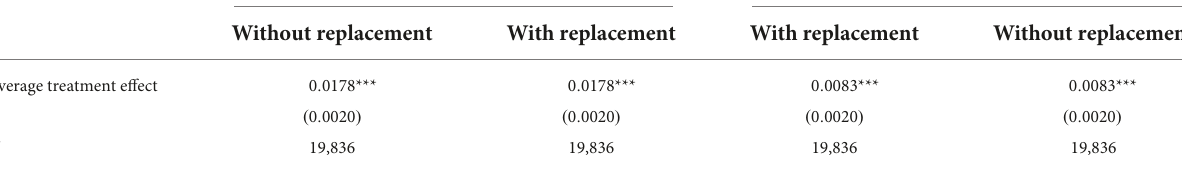
TABLE 7 PSM treatment effect of donation_if on outcome variable ROA. Category Nearest neighbor matching Year-by-year matching Without replacement With replacement With replacement Without replacement Average treatment